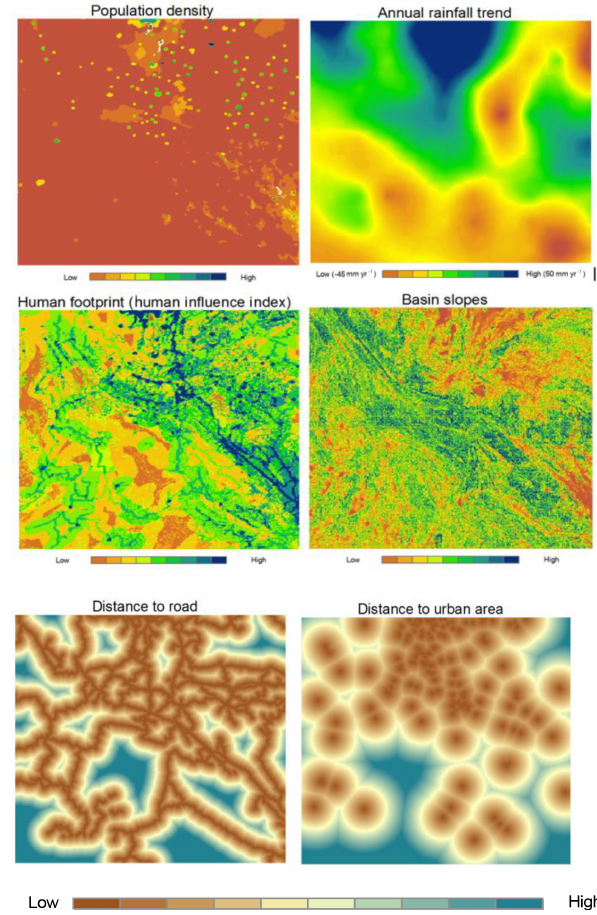
Figure 3. Selected drive factors for